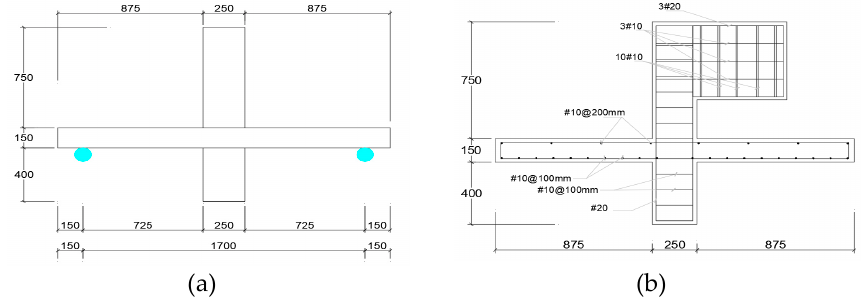
Figure 13. ( a ) Test specimen for applying concentric gravity load and ( b ) test specimen for applying concentric and eccentric loading [36].